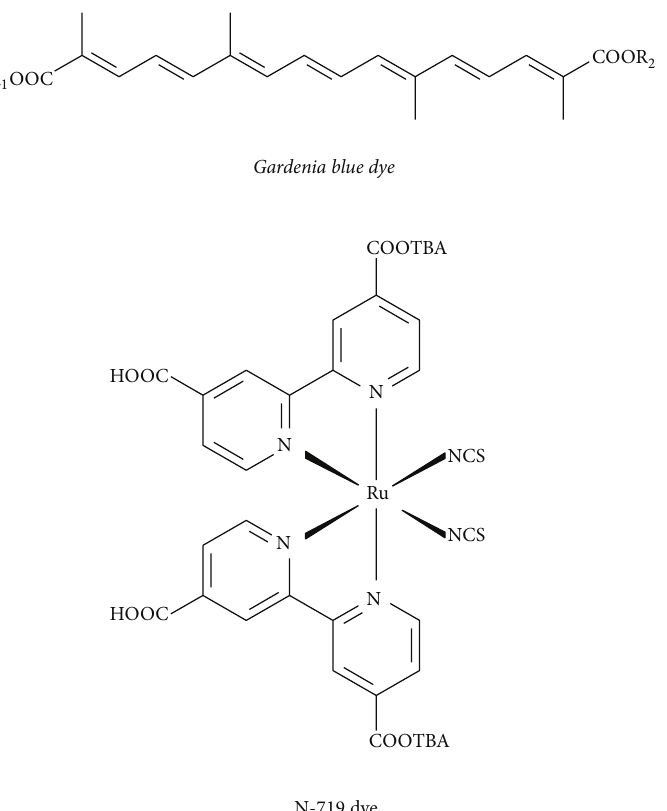
Figure 1: Chemical structure of Gardenia blue and N-719 (N-719 chemical name is cis-diisothiocyanato-bis(2,20-bipyridyl-4,40- dicarboxylato) ruthenium(II) bis (tetrabutylammonium); COOTBA is carboxylatotetrabutylammonium).